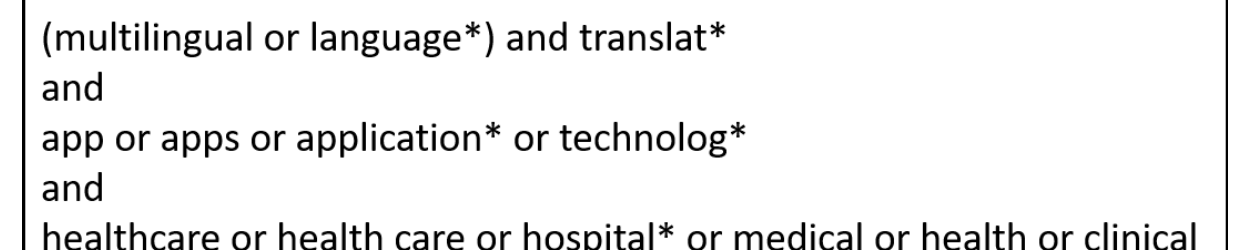
Figure 2. Search Terms for Literature, iMedicalApps and Google